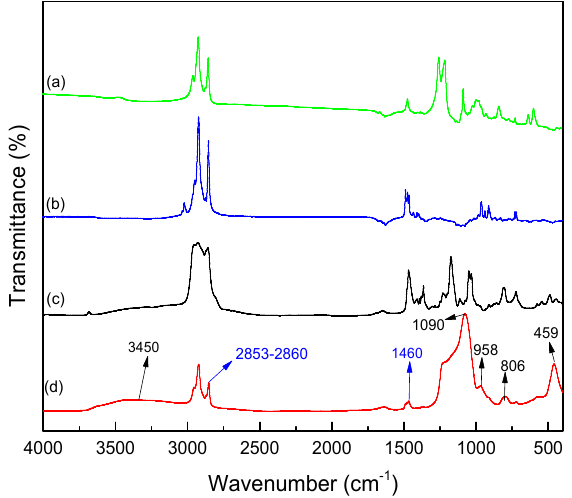
Figure 5. FT-IR spectrum of ( a ) sodium dodecyl sulfate (SDS), ( b ) cetyltrimethylammonium bromide (CTAB), ( c ) IL 104 and ( d ) SiO 2 @IL .